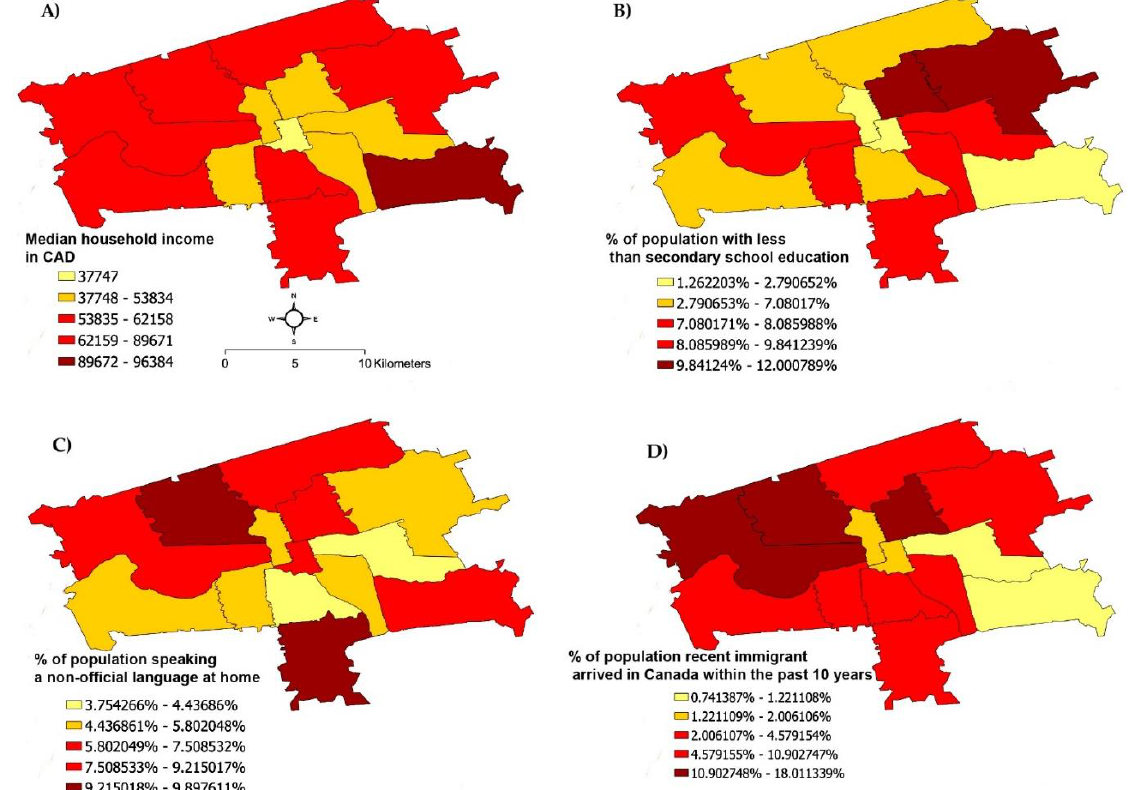
Figure 1. Geographic distribution of selected sociodemographic variables with the 14 FSA codes that lie within the City of London, Ontario, Canada: ( A ) median household income, ( B ) percentage of the population with less than secondary school education, ( C ) percentage of the population speaking a non-official language at home, and ( D ) percentage of the population who are recent immigrants (arrived in Canada in the past 10 years). Maps were created using data from Statistics Canada [17], with each outlined area representing a single FSA code. Distance scale in A applies to all panels.